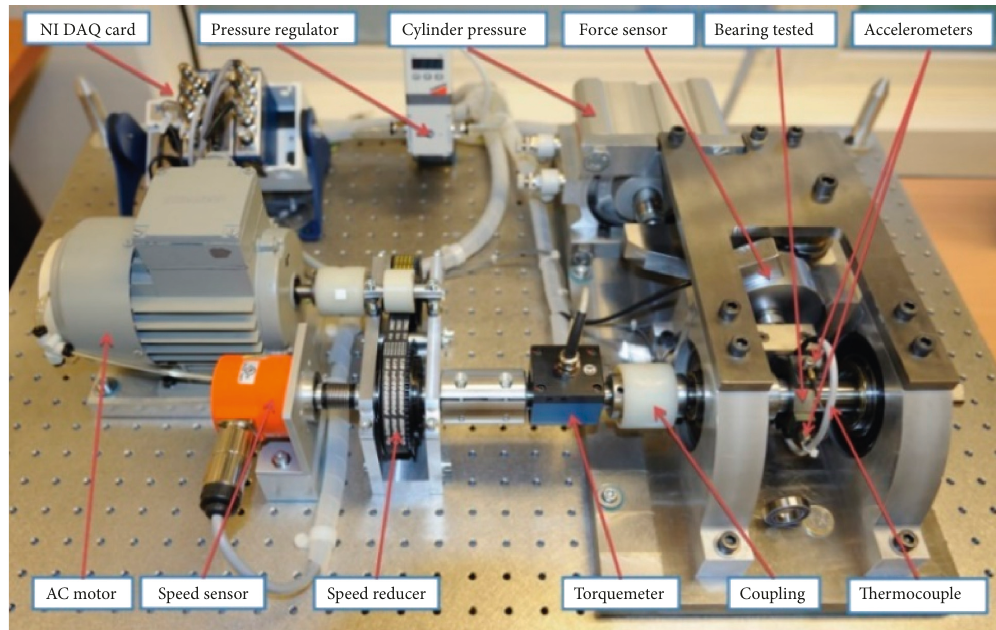
Figure 22: Overview of PRONOSTIA.